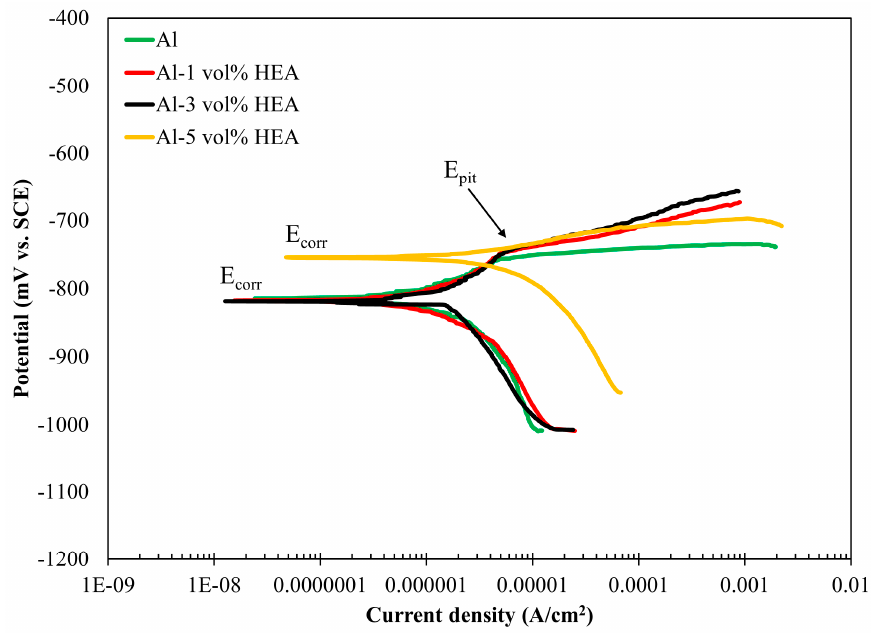
Figure 6. Potentiodynamic polarisation curves for Al and Al-HEA composites in aerated 3.5% NaCl solution.